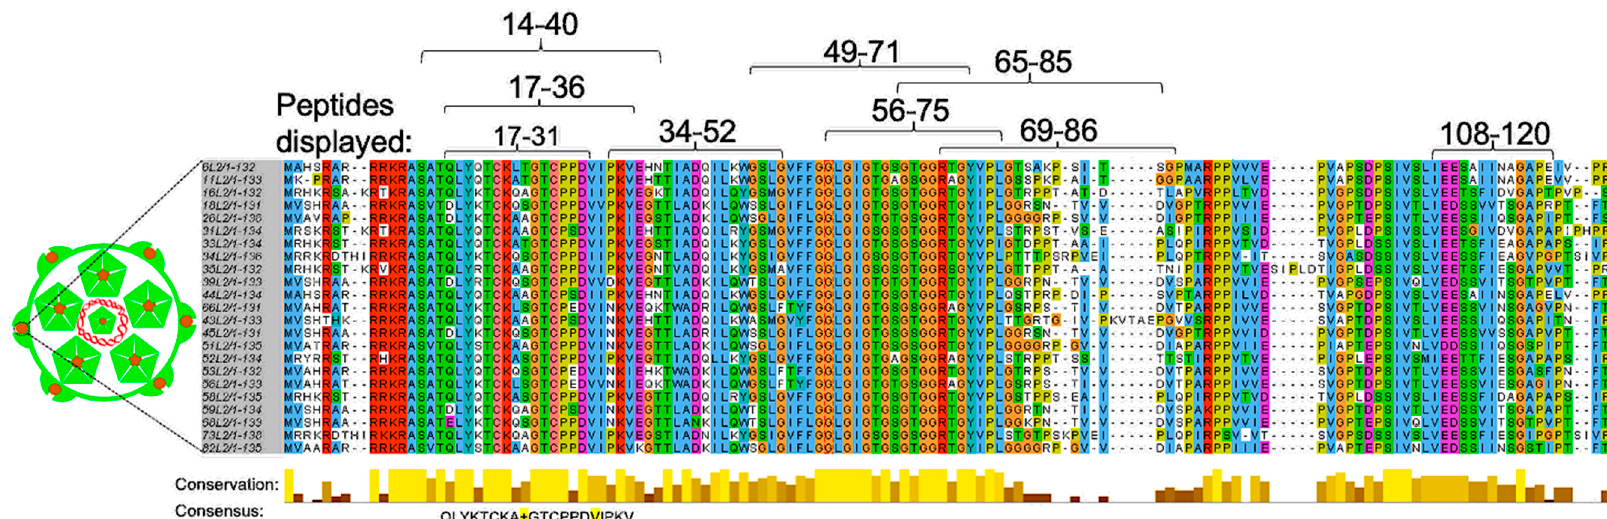
Figure 3. Sequence alignment of L2 (aa 1–135) from different HPV types. Sequence alignment was done using sequences from both high ‐ risk (HPVs 16, 18, 26, 31, 33, 34, 35, 39, 45, 51–53, 56, 58, 59, 66, 68, 73, and 82) and low ‐ risk HPV types (HPVs 6, 11, 43, and 44). Alignment was done using Jalview software. Residues that are highly conserved among different HPV types are highlighted, below the alignment, in gold bars. A consensus sequence of amino acid 17–36 from different HPV types is shown below the bars. Amino acid residues (in the consensus sequence) that differ from HPV16 L2 are highlighted in yellow background. The numbers above sequence alignment represent peptides (amino acid residues) that have been displayed on different VLP platforms (see Tables 1 and 2 for details).